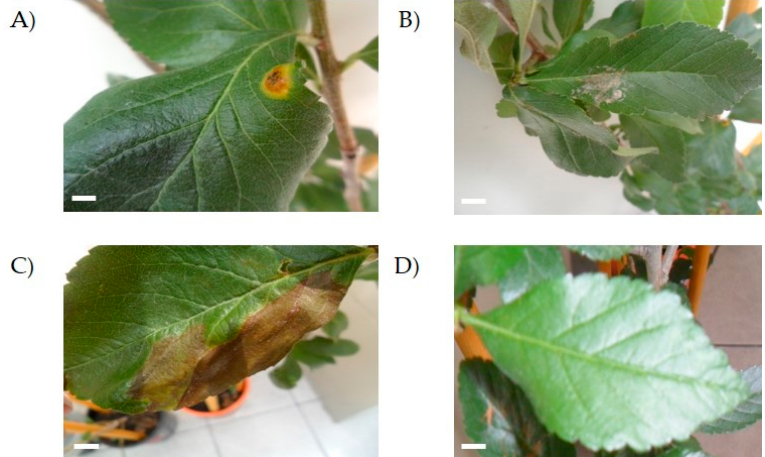
Figure 4. Pathogenicity test in healthy Crataegus sp. trees . The image shows injuries produced by isolates UAP140 ( A ), UAP168 ( B ) and UAP127 ( C ) in three-month-old trees. Control trees remained uninfected 35 days after infection ( D ). Scale bar = 0.5 mm.